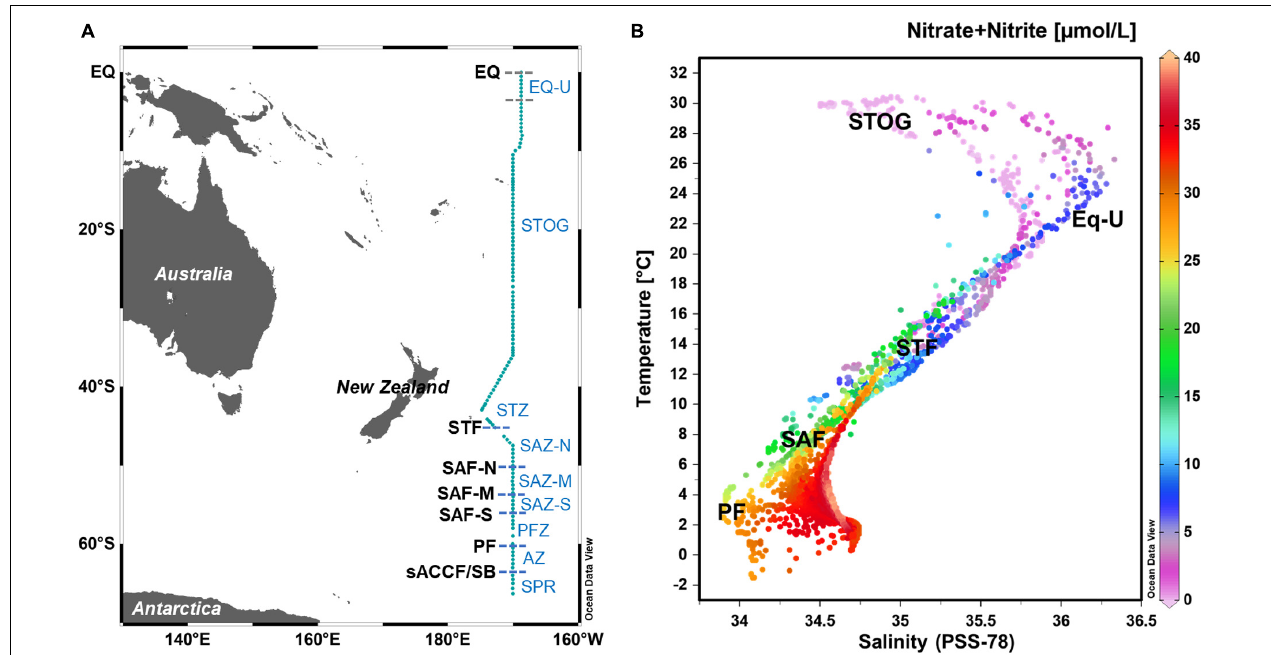
FIGURE 1 | (A) Map depicting microbial sampling stations within the GO-SHIP P15S transect (teal line) with approximate locations (latitudes) of the major oceanic fronts. (B) Plot of temperature against salinity (T-S) overlaid with nitrate + nitrite (NOx), with indicative temperature-salinity-NOx ranges of the different oceanic zones. T-S plots were generated using data recorded from all depths measured within the full water column. EQ, equator; EQ-U, equatorial upwelling zone; STOG, subtropical oligotrophic gyre zone; STZ, subtropical zone; SAZ-N, subantarctic zone-north; SAZ-M, SAZ-mid; SAZ-S, SAZ-south; PFZ, polar frontal zone; AZ, Antarctic zone; sACCF, southern Antarctic circumpolar current front; SPR, subpolar